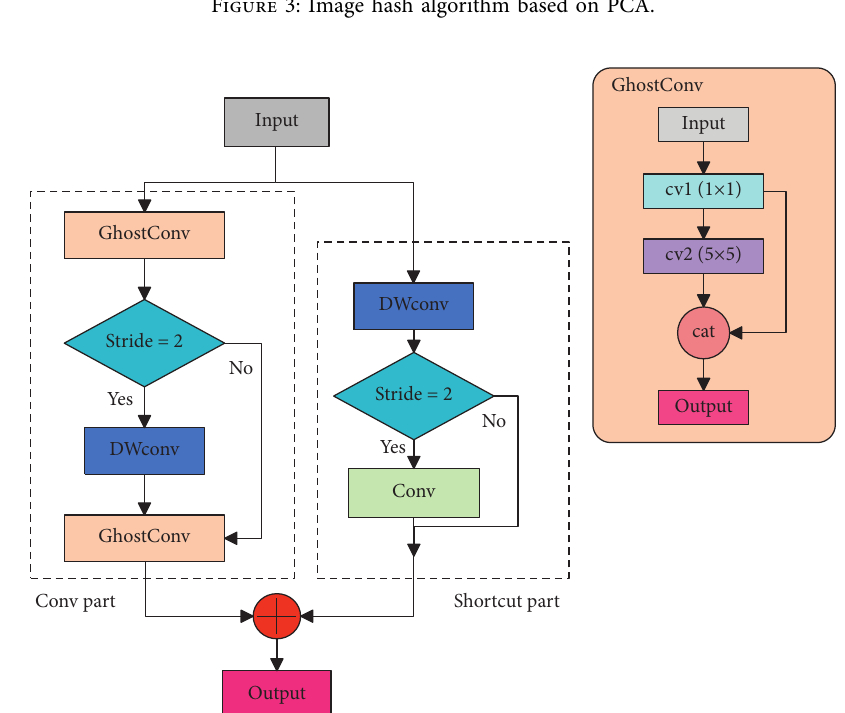
Figure 4: GhostBottleneck